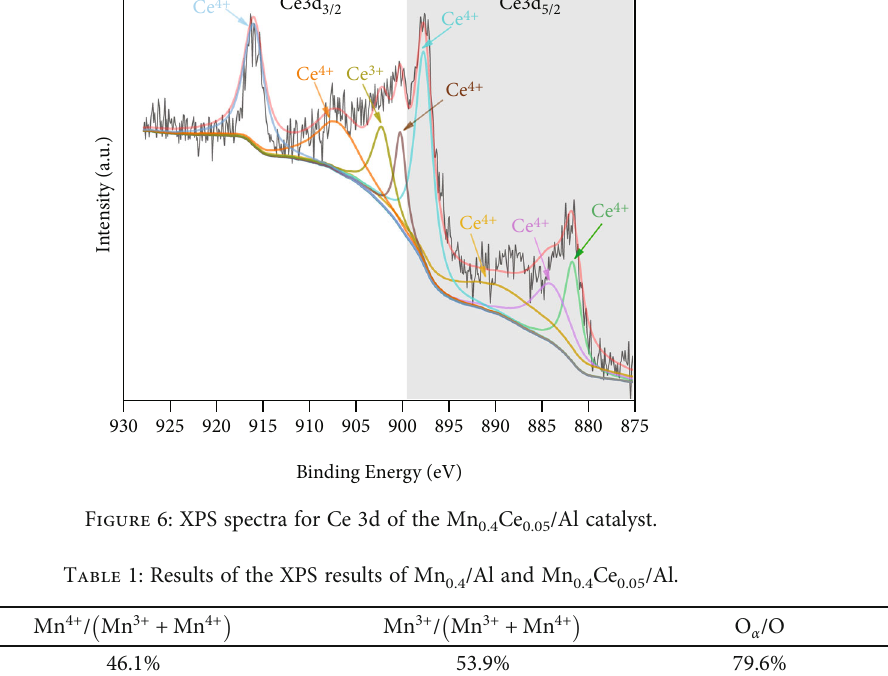
/Al catalyst and (b) the Mn 0.4